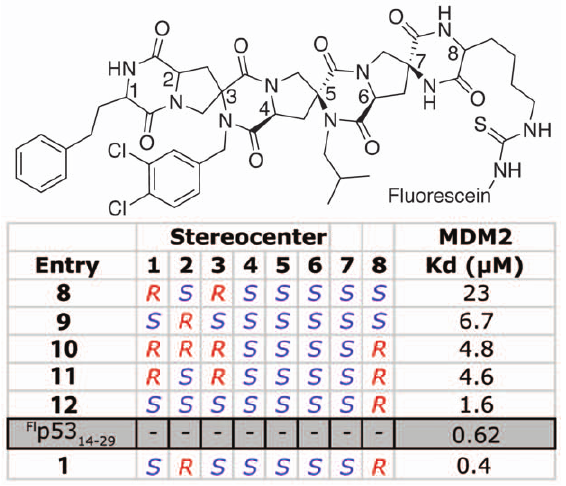
Figure 4. The stereoisomers 8–12 and 1 were suggested by CANDO as being able to mimic the presentation of the side- chains of p53 when bound to HDM2.